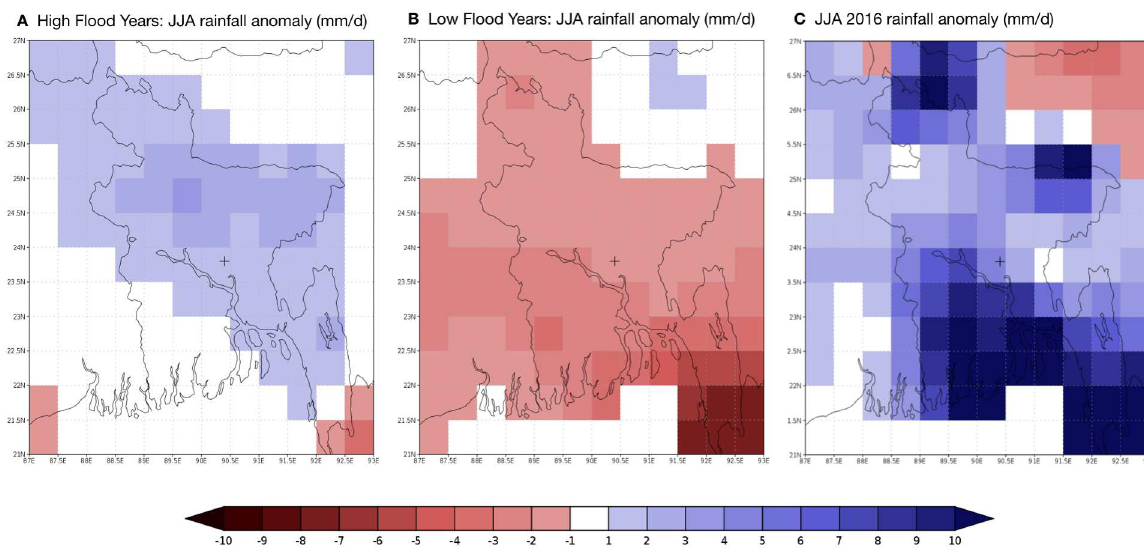
Fig 3. Deviation from climatological June-August rainfall for (A) five high flooding years, (B) five low flooding years, and (C) 2016. Units are (mm/d). The cross symbol indicatesthe locationof